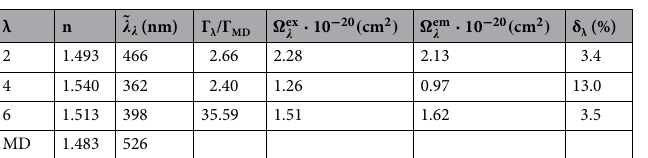
Table 3. JO parameters estimated from the excitation spectrum of β-NaYF 4 :Eu 3+